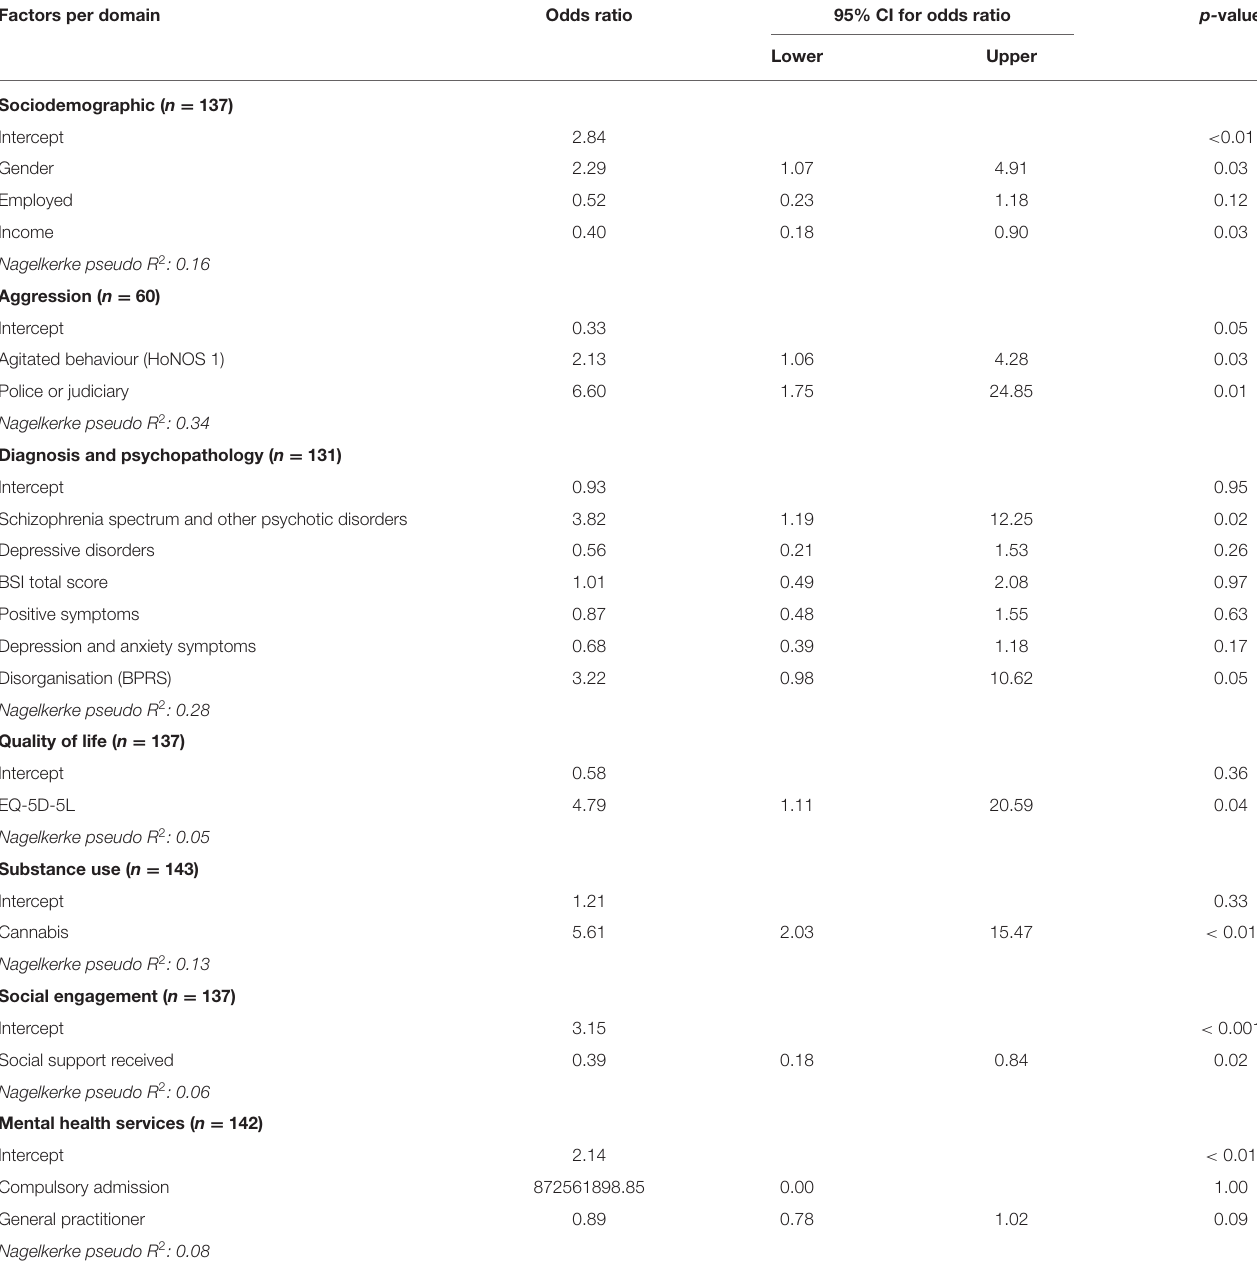
TABLE 2 | Explained variance in the different domains related to hospitalisation. Factors per domain Odds ratio 95% CI for odds ratio p- value